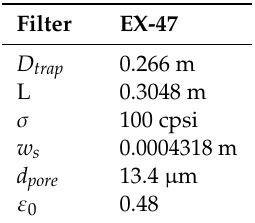
Table 1. Cordierite filter